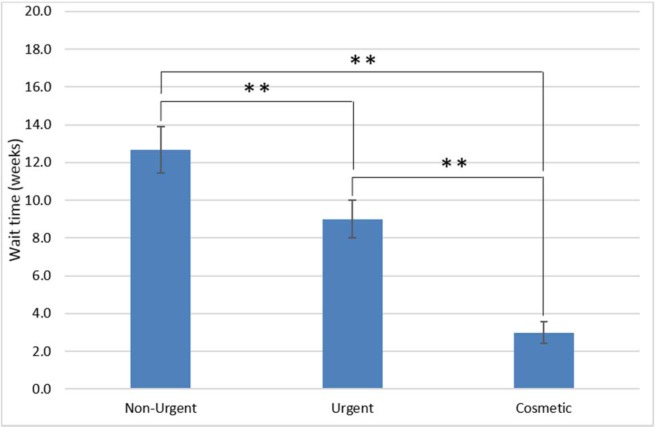
Wait times for dermatologic care across the province of Ontario for access to Non-Urgent, Urgent, and Cosmetic dermatologic services.Errors bars reflect Standard Error of the Mean (sem). **P <0.001.